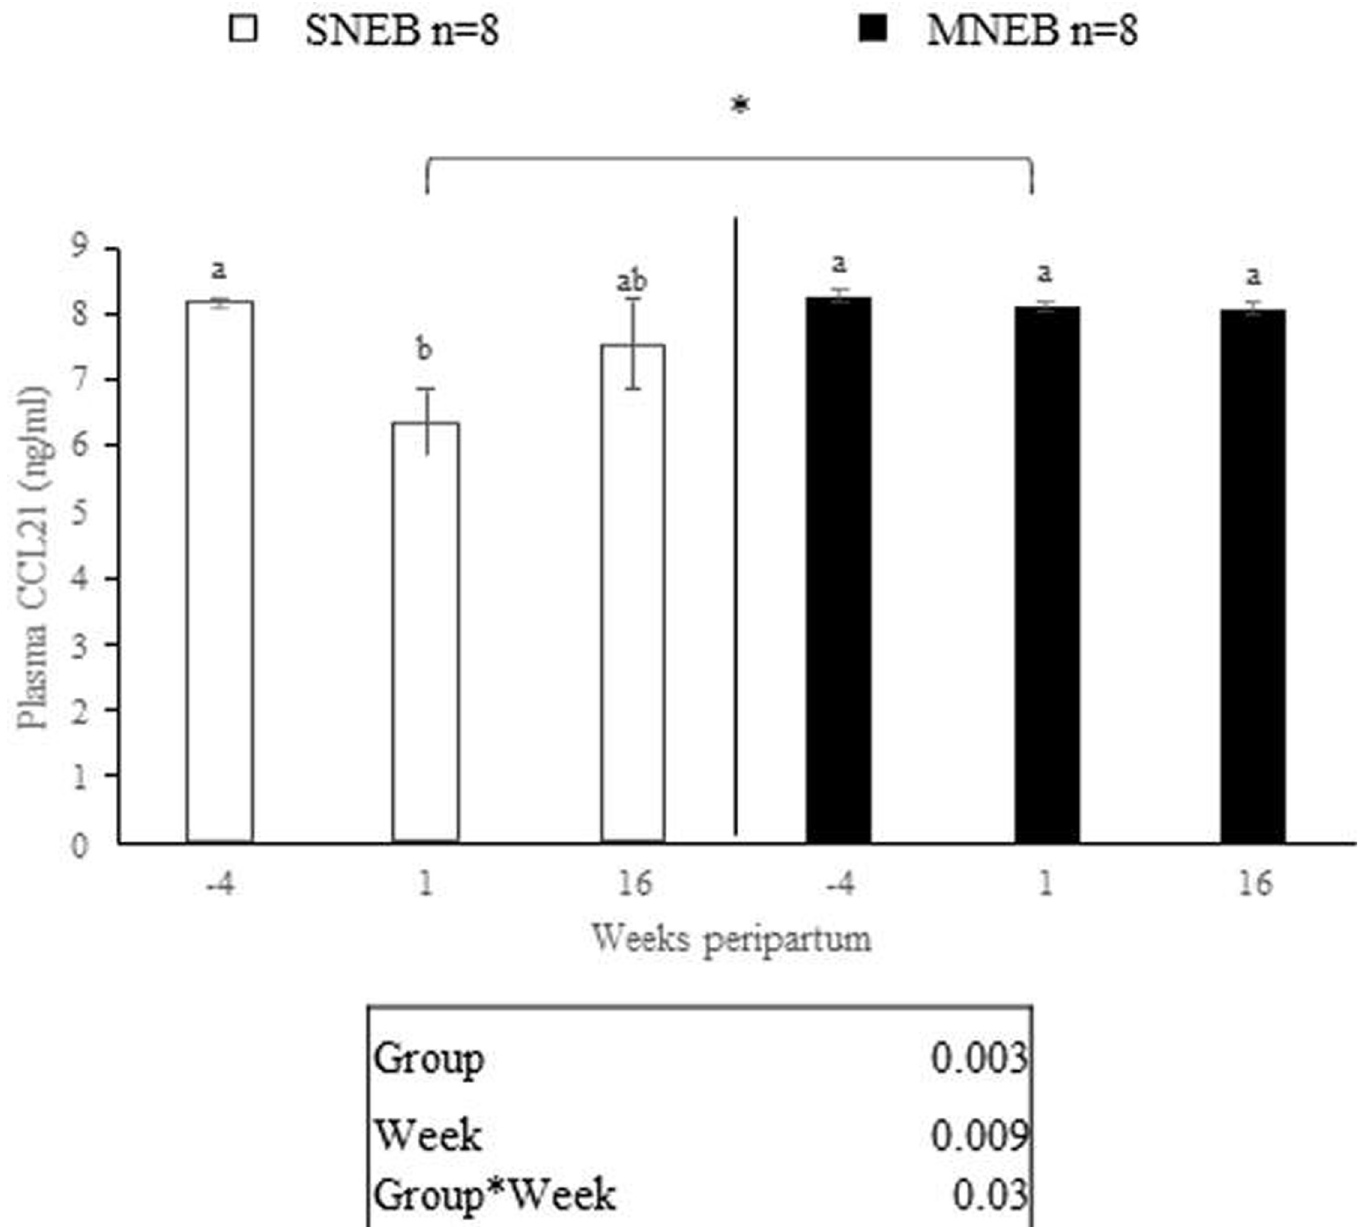
Fig 7. Concentration of CCL21 in plasma of cows either with severe (SNEB) or moderate (MNEB) negative energy balance. Plasma level of CCL21 was determined by ELISA assay after collecting blood at -4, 1, and 16 weeks peripartum (wkpp) of cows with SNEB (n = 8) or low NEB (n = 8). Results are represented as LSM ± SEM. Low case letters represent a significant ( P < 0.05) time effect separately in the group SNEB and MNEB and � represents a significant ( P < 0. 05) group effect.